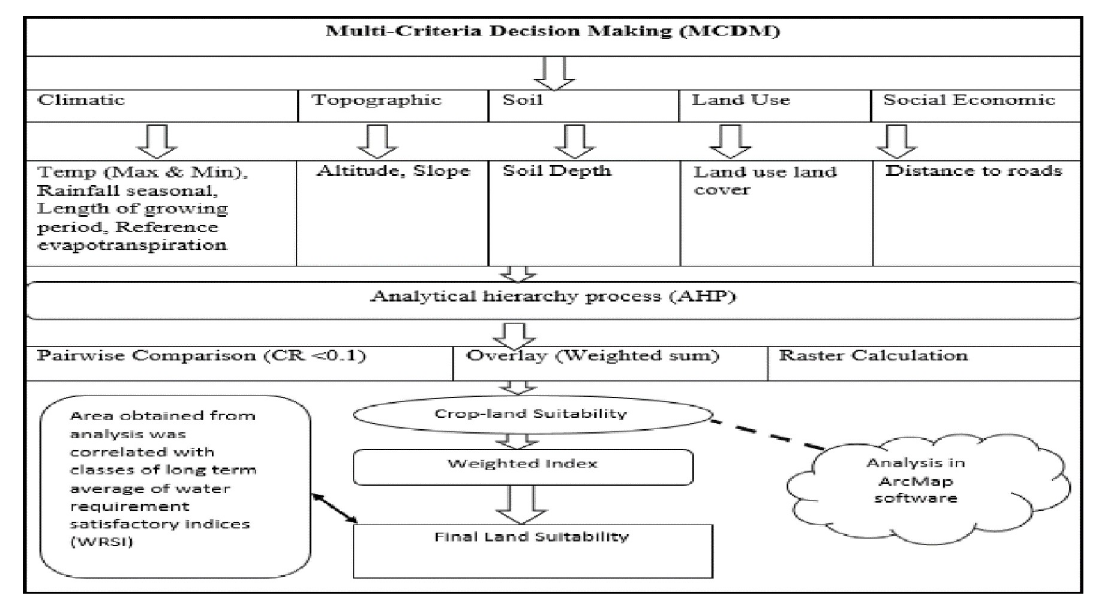
Fig 1. Framework used in computing suitability indices for neglected and underutilised crop species in South Africa (developed by the authors).